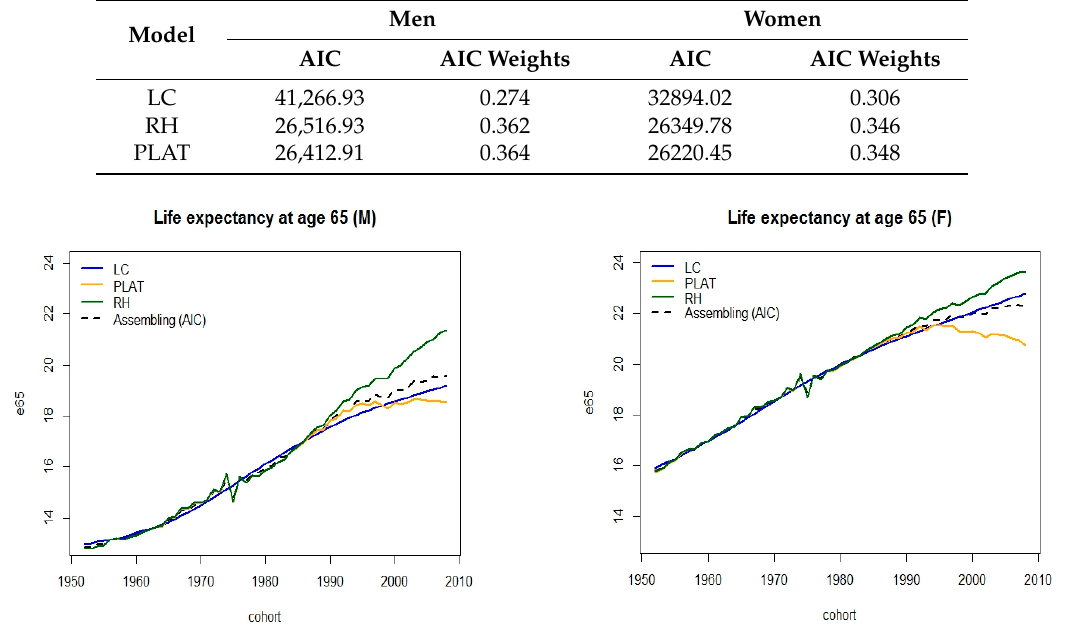
Figure 2. Life expectancy at age 65 for the selected cohorts and models.